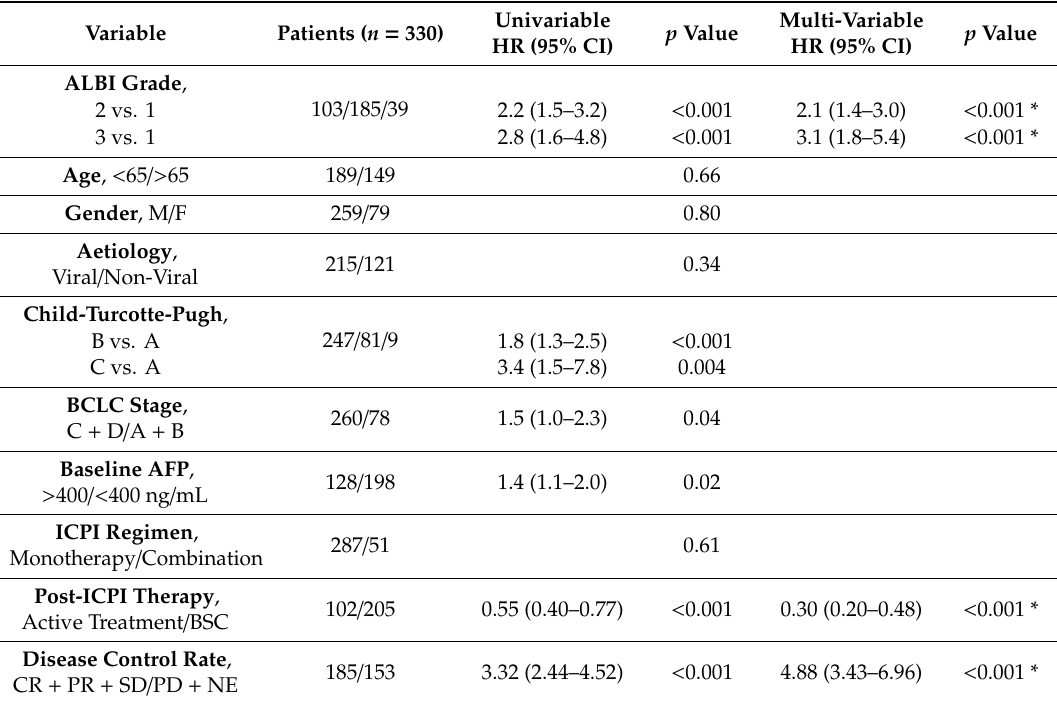
Table 4. Uni- and multi-variable analysis of survival in patients with HCC treated with